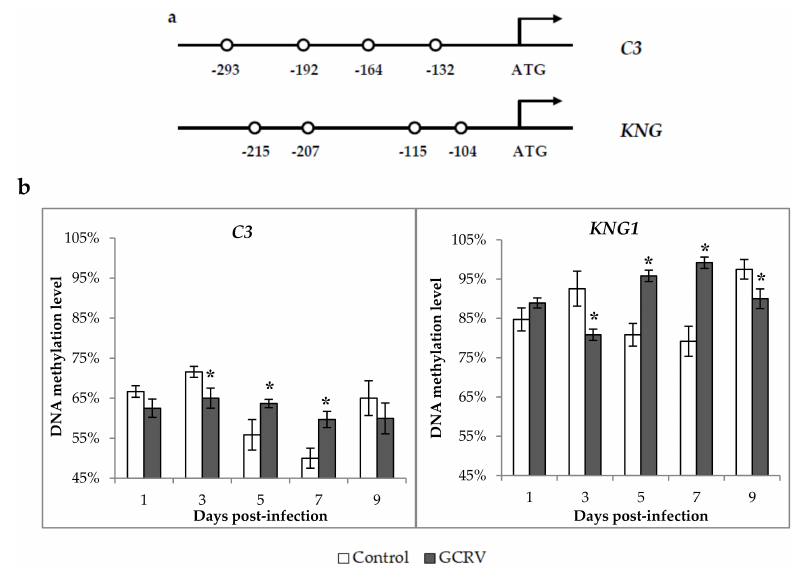
Figure 6. The DNA methylation level in the 5 (cid:48) flanking region of C3 and KNG1 after GCRV infection. ( a ) A schematic diagram of CpG loci in the 5 (cid:48) flanking region of C3 and KNG1 genes. Four CpG loci were selected in both C3 (-293, -192, -164, and -132) and KNG1 (-215, -207, -115, and -104) genes for BSP-PCR. ( b ) Changes of DNA methylation levels after GCRV infection. Data are shown as the mean ± standard deviation of three biological duplicates ( n = 5 for each biological duplicate). Significant difference ( p < 0.05) in DNA methylation level between the two groups are indicated with an asterisk (*).